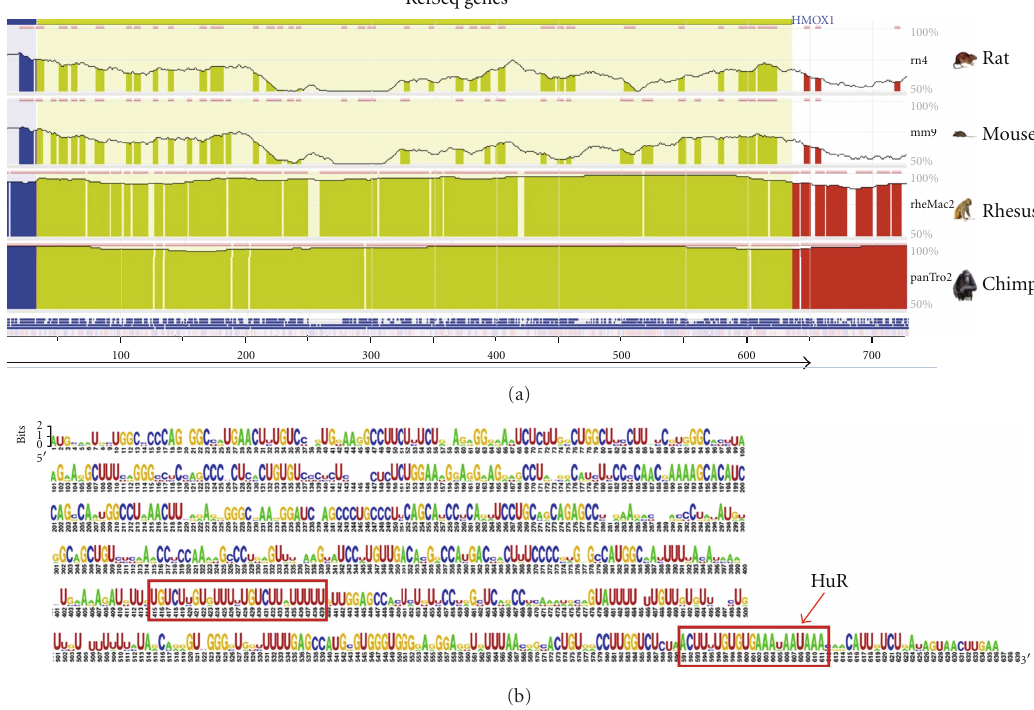
Figure 7: Comparison of the 3 (cid:3) -UTR of the HO-1 mRNA of di ff erent species. (a) The 3 (cid:3) -UTR sequences of the HO-1 mRNA from rat, mouse, rhesus macaque, chimpanzee and human was compared using the ECR-Browser software. The search area was 10 bp and the minimal homology was 80%. The height of the curves (50% < X < 100%) indicates the homology (red = intergenic regions, yellow = untranslated regions of the RNA (UTR), blue = exon, pink ECR, above). (b) Using the software RNALogo (http://rnalogo.mbc.nctu.edu.tw/createlogo.html) a consensus sequence of all 5 3 (cid:3) -UTR sequences was generated. The height of the letters indicate the frequency of the appearance of this base. AREs are marked by a red box. A putative HuR binding site is indicated.